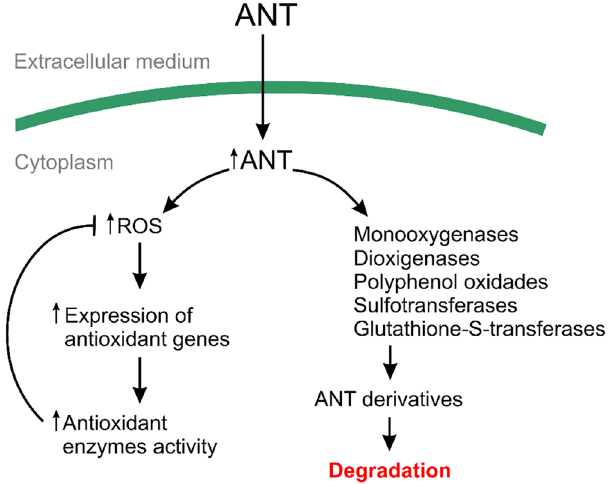
Figure 8. Model of anthracene detoxification in the marine alga U. lactuca . The alga cultivated with ANT rapidly incorporate and degrade this molecule showing an increase in ANT in the alga. ANT induces an oxidative stress condition leading to an increased expression of genes encoding antioxidant enzymes and their activities. Intracellular ANT is the substrate of metabolizing enzymes such as monooxygenases, dioxygenases, polyphenol oxidases, glutathione- S -transferases, and